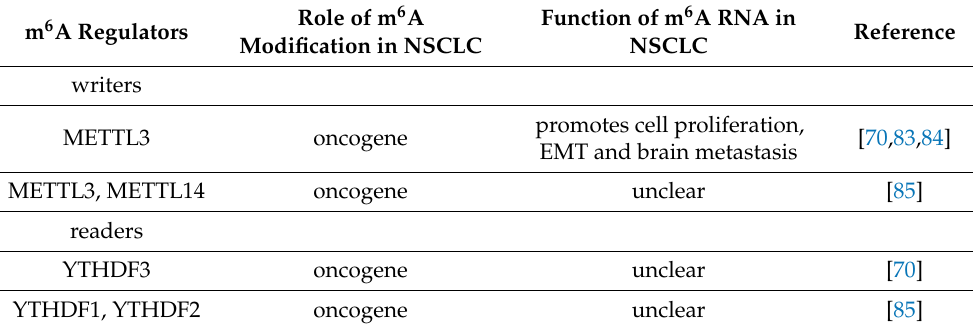
Table 3. Effects of m 6 A long noncoding RNAs (lncRNAs) modification on